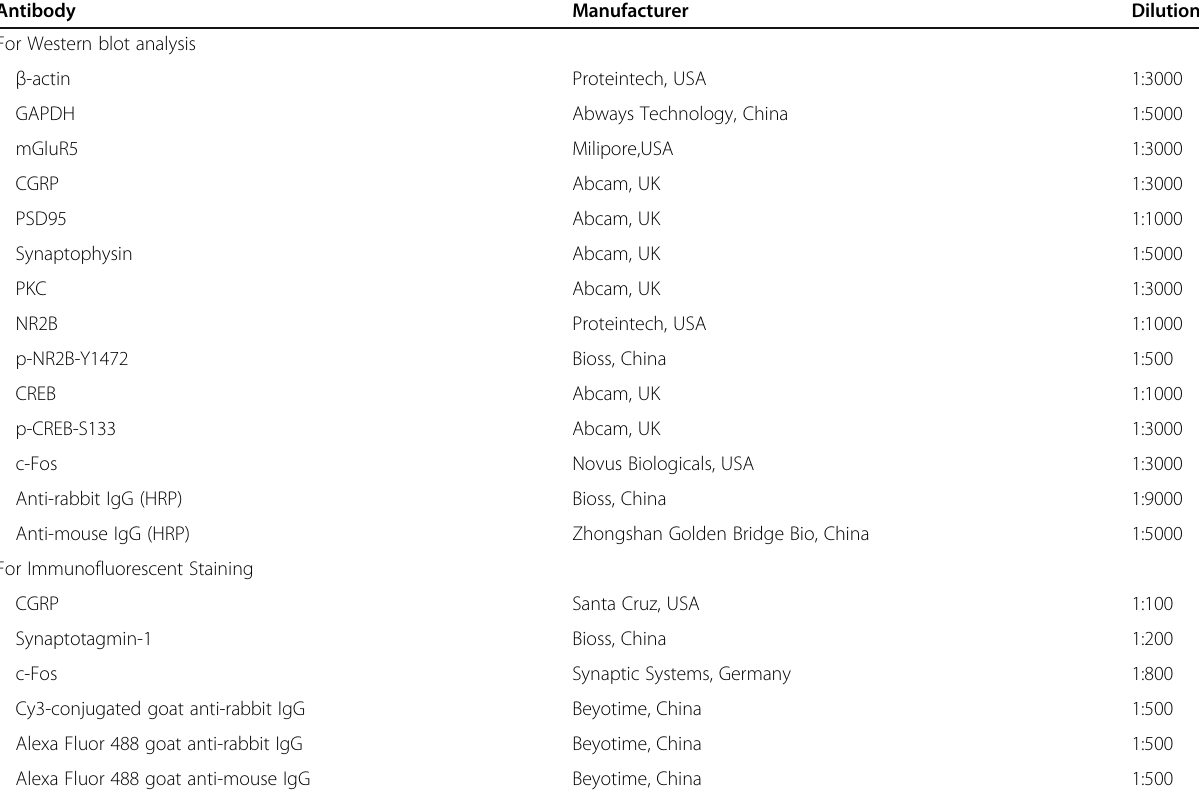
Table 2 Antibodies used in Western blot analysis and immunofluorescent staining